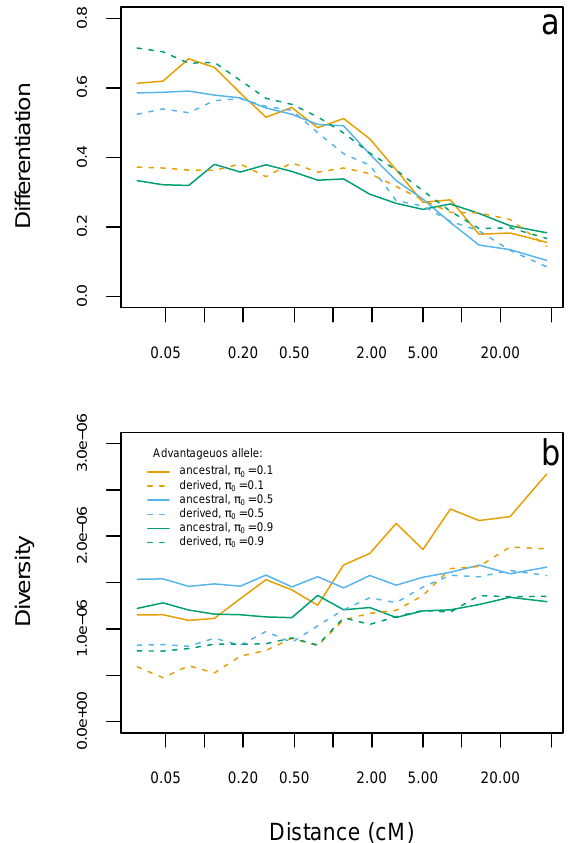
Figure 9 – Effect of recombination occurring before the selective sweep on differenti- ation and diversity of the haplotypes carrying the advantageous allele. Genetic patters found in a simulated population of N = 500 diploid individuals reproducing predomi- nantly by selfing ( σ = 0.95 ) after 20 N e generations. (a) Differentiation is measured as the F ST between haplotypes carrying the advantageous allele and those carrying the alternative allele. (b) Diversity is measured as the average heterozygosity per bp. Both differentiation and diversity were calculated on 3 000 bp windows at different distances to the loci under selection. The mean from 100 simulation replicates is